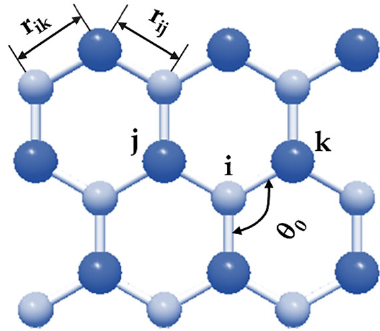
Figure 4. Section of the InN nanostructure showing r ij , r ik and θ 0 . N atoms are represented in pale blue and In atoms are in bright blue.